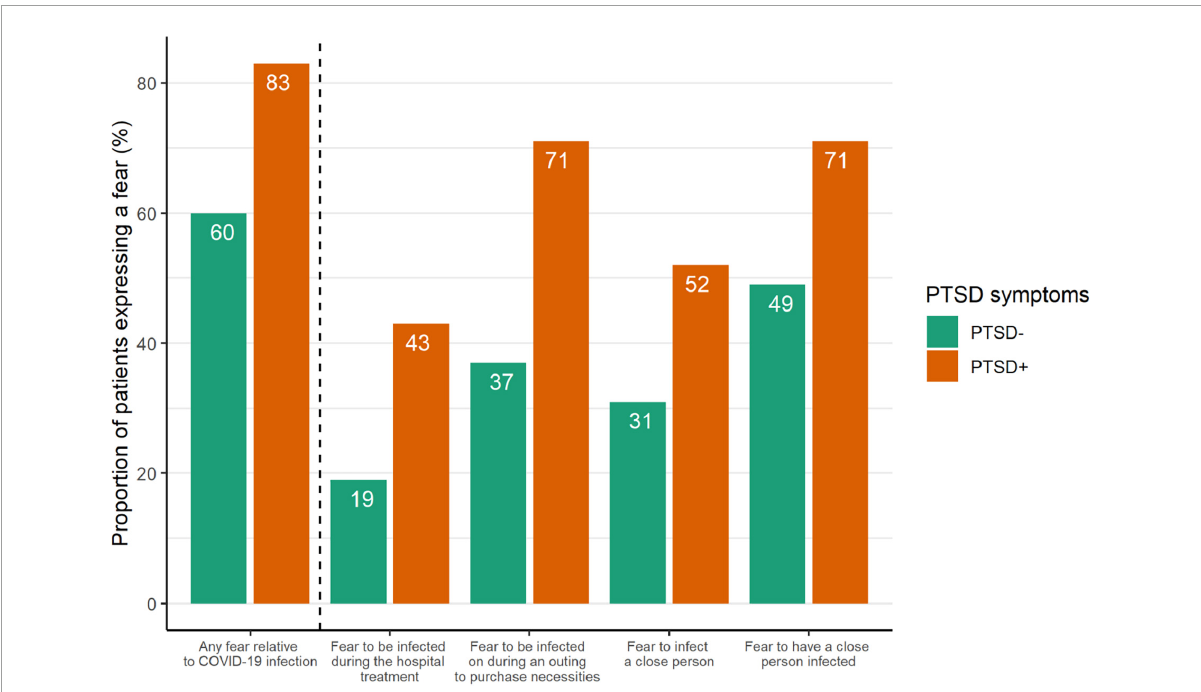
FIGURE1 Proportion of breast cancer (BC) patients expressing fears relative to coronavirus disease (COVID-19) infection by post-traumatic stress disorder (PTSD) symptoms ( N = 183). Date are issued from the questionnaire which assessed social and psychological experiences during the first COVID-19 lockdown. Patients scored their fears of COVID-19 infection (4 items: fear to be infected during the hospital treatment, fear to be infected during outing to purchase necessities, fear to infect a close person, and fear to have a close person infected) on a 4-point Likert scale that were dichotomized for analysis (“not at all/yes, a little” vs. “yes, moderately/yes, a lot”).